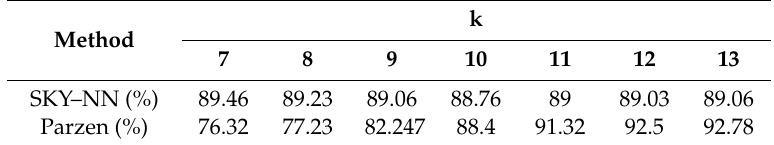
Table 26. Opposite skyline on the real dataset.